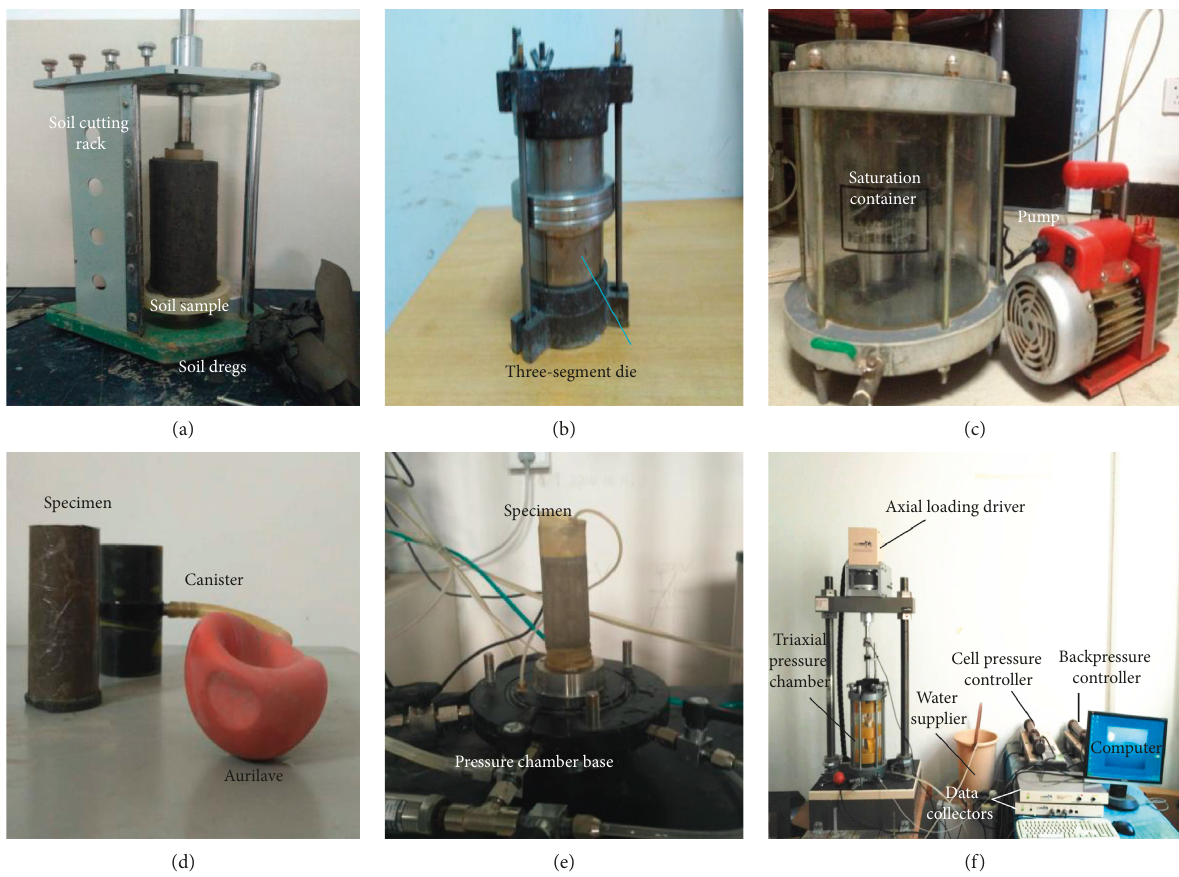
Figure 5: Specimen preparation process for a cyclic triaxial test: (a) cutting the soil; (b) placing the specimen in the three-segment die; (c) saturating in the saturation container; (d) covering the specimen; (e) installing the specimen; (f) conducting the cyclic triaxial test.